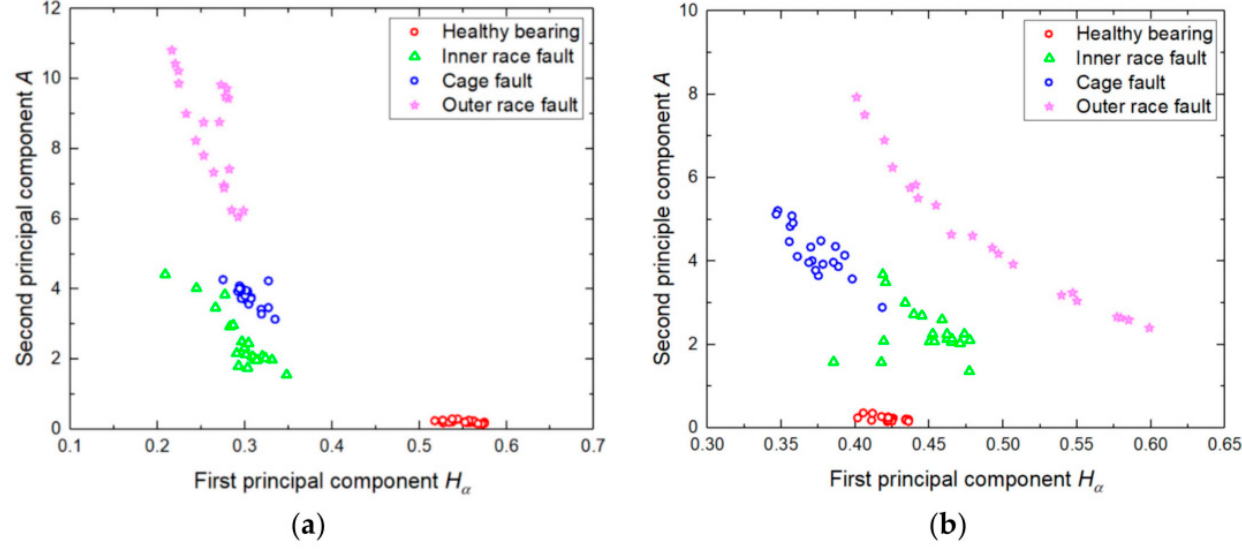
Figure 43. Testing results for multiple kinds of bearing faults by implementing (a) DFA and (b) IDFA [116].